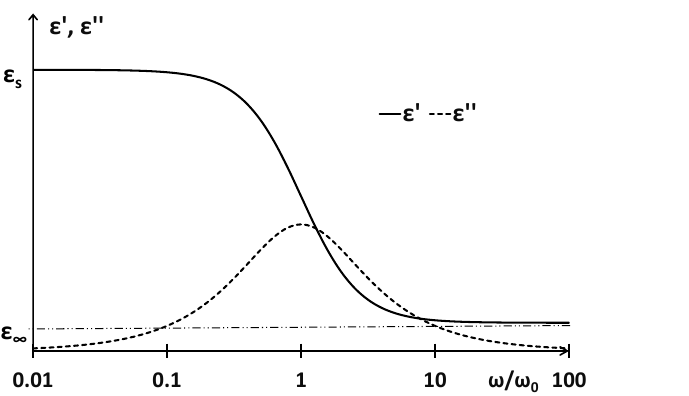
Figure 3. The relationship between real ( ε (cid:48) ) and imaginary ( ε (cid:48)(cid:48) ) parts of permittivity in case of one Debye relaxation. Figure 3 The relationship between real ( (cid:905) (cid:514)(cid:508) and imaginary ( (cid:905) (cid:514)(cid:514)(cid:508) parts of permittivity in case of one Debye 144 relaxation. 145